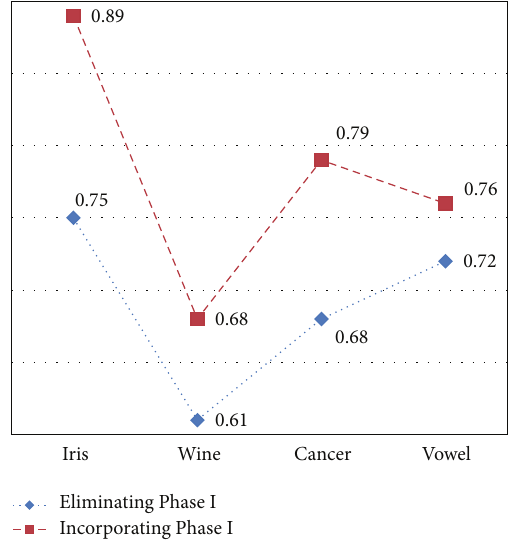
Figure 4: Accuracy of proposed method with and without Phase I. Figure 5: Validity of proposed method with and without Phase